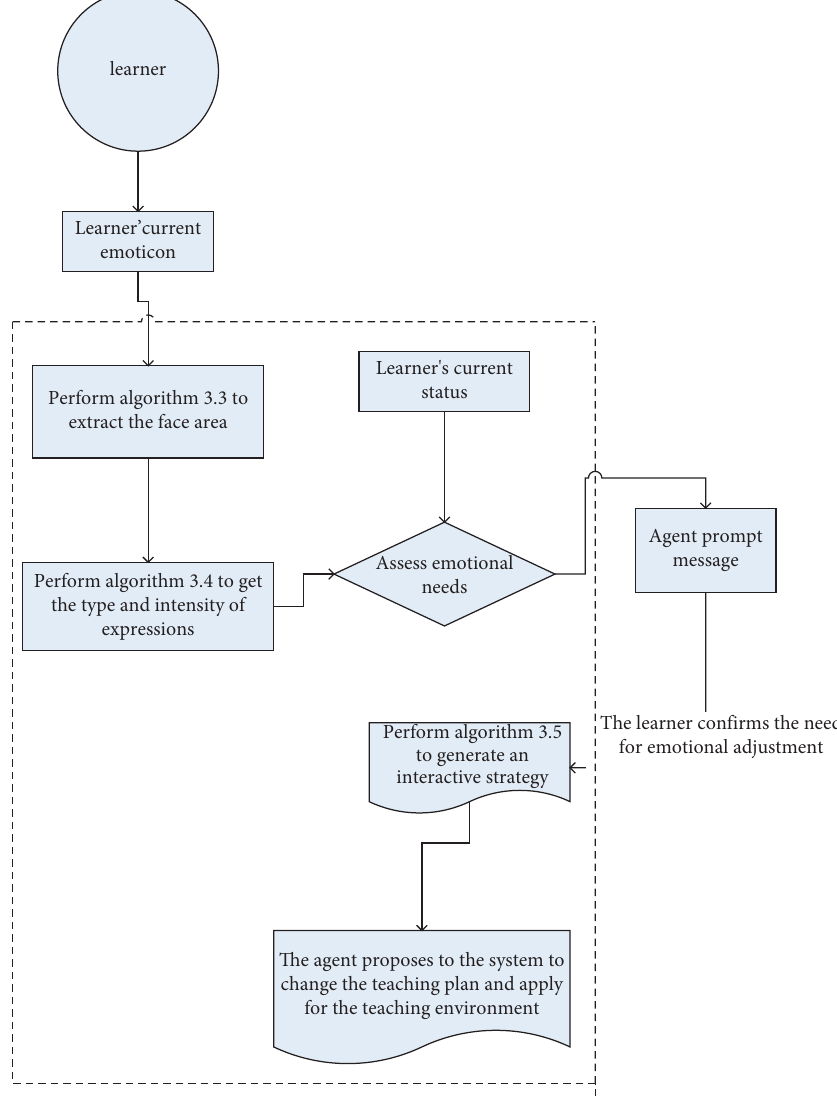
Figure 6: Agent emotion processing